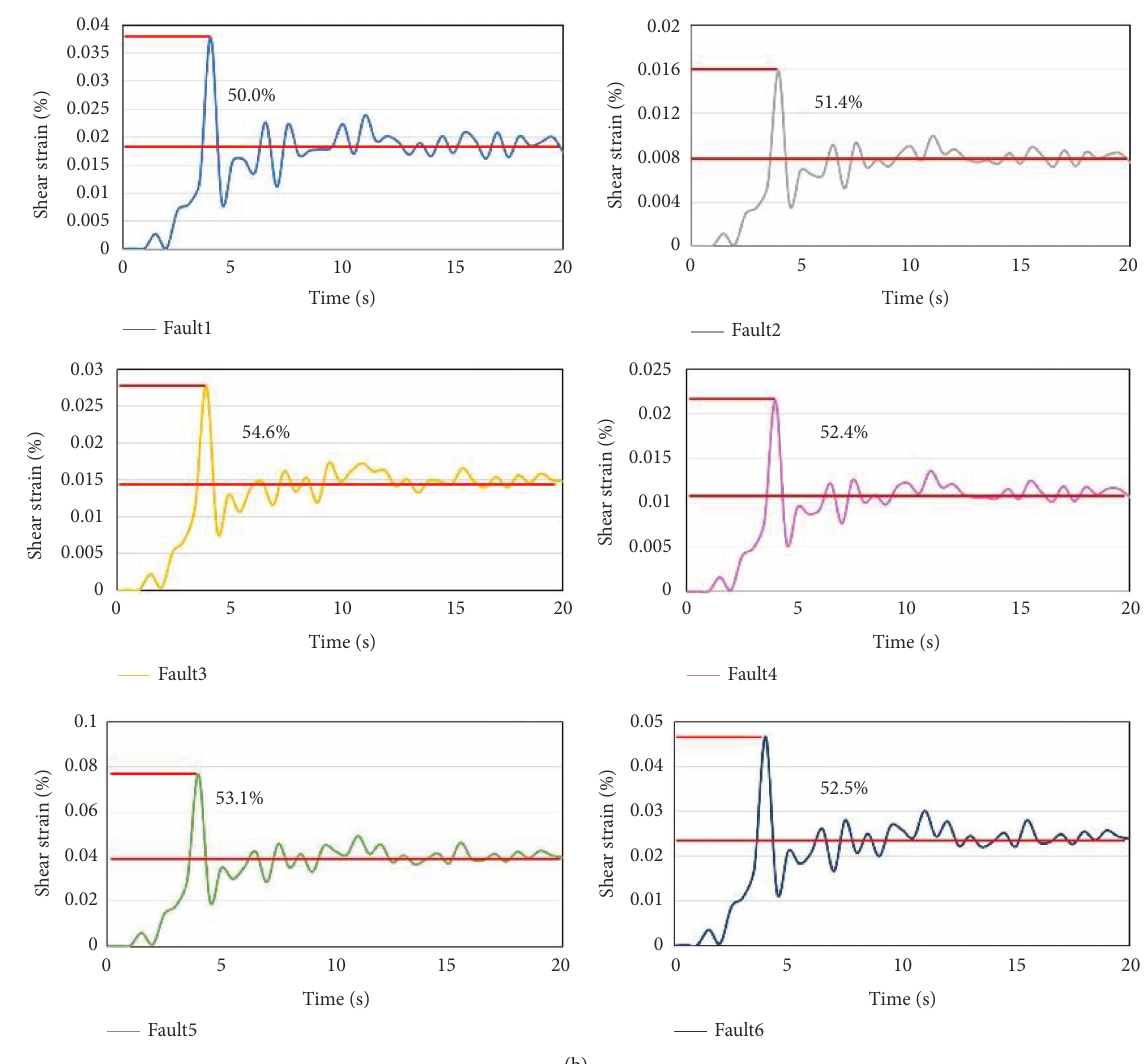
Figure 6: (a) Shear stress and (b) shear strain due to the M5.8 earthquake in the six fault gouges, which show that the residual-to-peak ratio is approximately 50%–55% for each fault